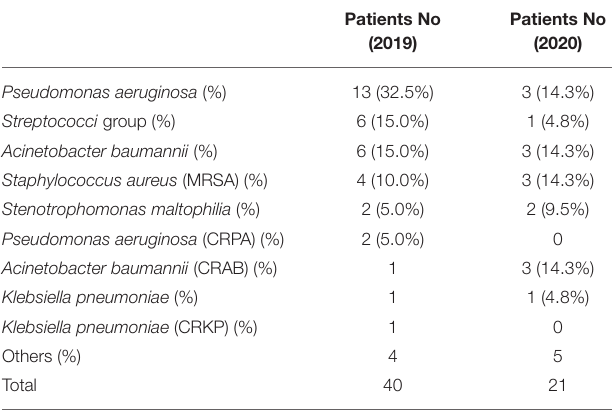
TABLE 4 | Identified pathogens in hospital- acquired pneumonia